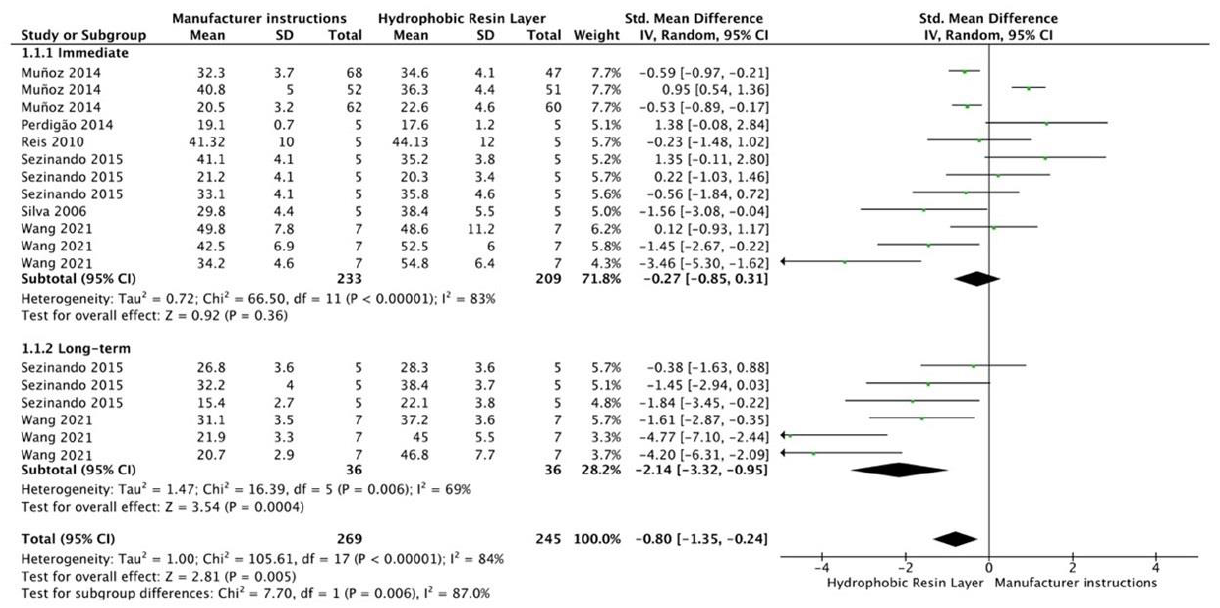
Figure 2. Forest plot showing the bond strength values when the adhesive was covered by a hydrophobic resin layer [63–68].